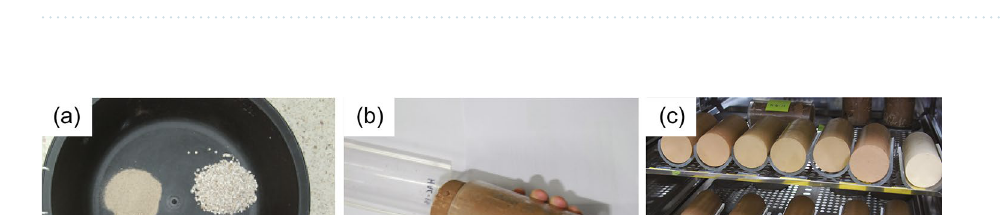
Table 2. Mixing ratios of constituent components used in each artificial specimen type.